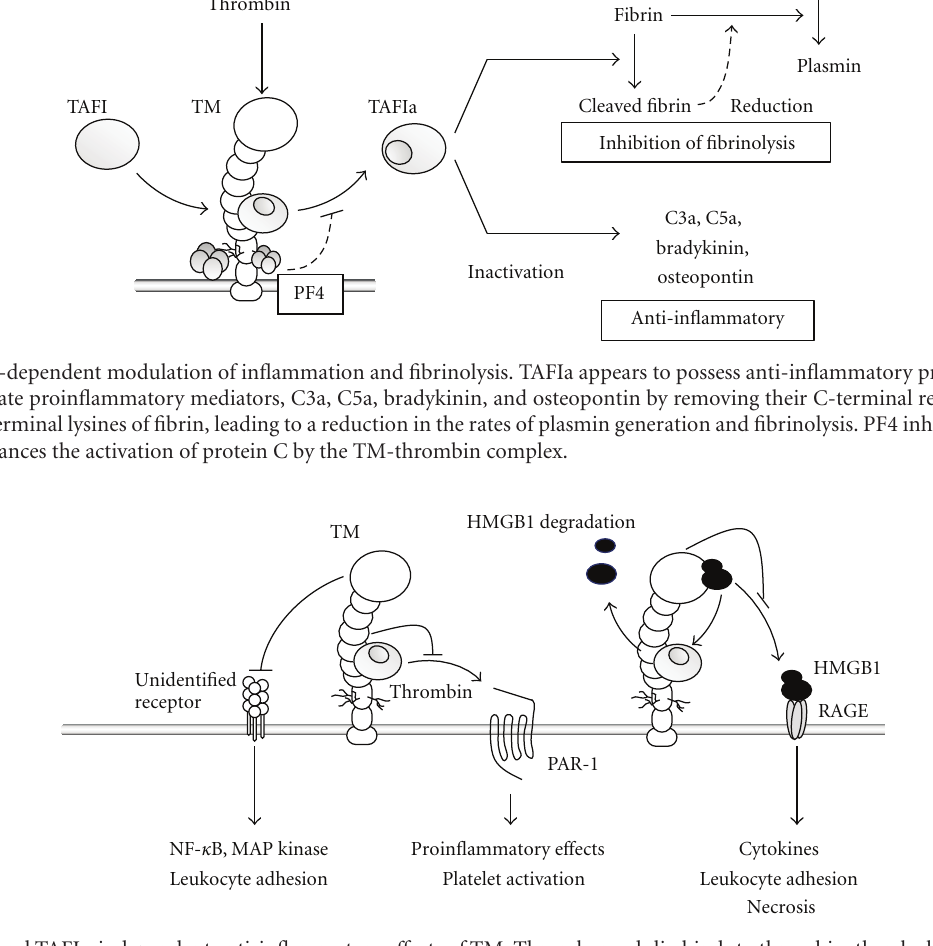
Figure 6: APC- and TAFIa-independent anti-inflammatory e ff ects of TM. Thrombomodulin binds to thrombin, thereby blocking activation of protease-activated receptors. The lectin-like domain binds to, and enhances degradation of, proinflammatory molecule HMGB1. In addition, the lectin-like domain is thought to bind to an unidentified receptor, thereby suppressing MAP kinase and NF- κ B